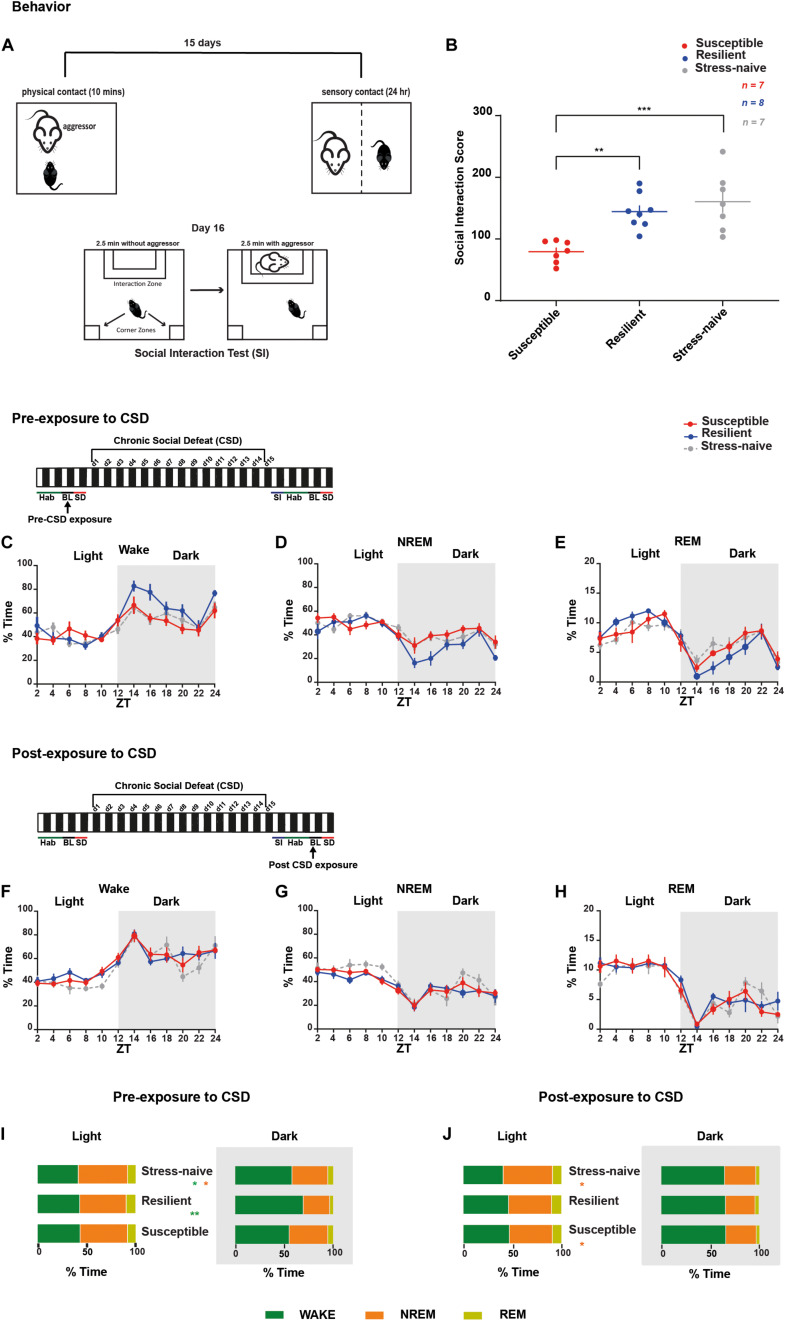
Sleep and wake states were assessed in mice pre- and post-CSD paradigm. Mice resilient to stress spent more time awake in the dark during pre-, but not post-exposure, to CSD stress. (A,B) Overview of the chronic social defeat (CSD) paradigm. (A) C57BL/6J mice were introduced into the cage of a novel and aggressive CD1 mouse for 10-min (physical aggression), then separated by a clear perforated plexiglass divider for the following 24-h (psychological aggression). Mice were exposed to a novel CD1 every day for 15 days. On day 16, the social interaction test was performed to assess the social avoidance behavior. (B) Social interaction score is defined as the percent ratio of the time spent in target-interaction zone to the time spent in no-target interaction zone. Both the stress-naïve and resilient mice exhibit a score >100, while the susceptible mice exhibit a score <100. There was a phenotype effect (F2,19 = 11.62, p < 0.001) as both resilient and stress-naïve exhibited a higher score than susceptible mice (p < 0.01 and p < 0.001, respectively). (C–E)
Pre-CSD stress: There was a “time” effect across all vigilance states (p < 0.0001). (C) Wake: There was a “time” x “phenotype” interaction effect (F22,202 = 1.736, p < 0.05). In the dark, there was a trend of “phenotype” effect (F2,18 = 3.11, p = 0.069). (D) NREM sleep: There was a “time” x “phenotype” interaction effect (F22,202 = 1.790, p < 0.05). In the dark, there was a trend of “phenotype” effect (F2,18 = 3.162, p = 0.067). (F–H) Post-CSD stress: There was a significant effect of “time” in all three subfigures (p < 0.0001). (I,J) A summary of the main findings showing: Pre-CSD stress:
(I) There was no difference in time spent in the different vigilance states between the phenotypes in the light. Resilient mice spent more time awake relative to susceptible and stress-naive mice in the dark (p < 0.01 and p < 0.05, respectively). Post-CSD stress: (J) Susceptible and Resilient mice spent less time in NREM sleep relative to stress-naïve mice during the light (p < 0.05 and p < 0.05, respectively). No difference was observed between the phenotypes in the amount of time spent in the different vigilance states during the dark. Values are expressed as percentage of total recording time (mean ± sem) averaged across 2-h (C–H) or 12-h intervals (I,J). n = 7–8 for each group.